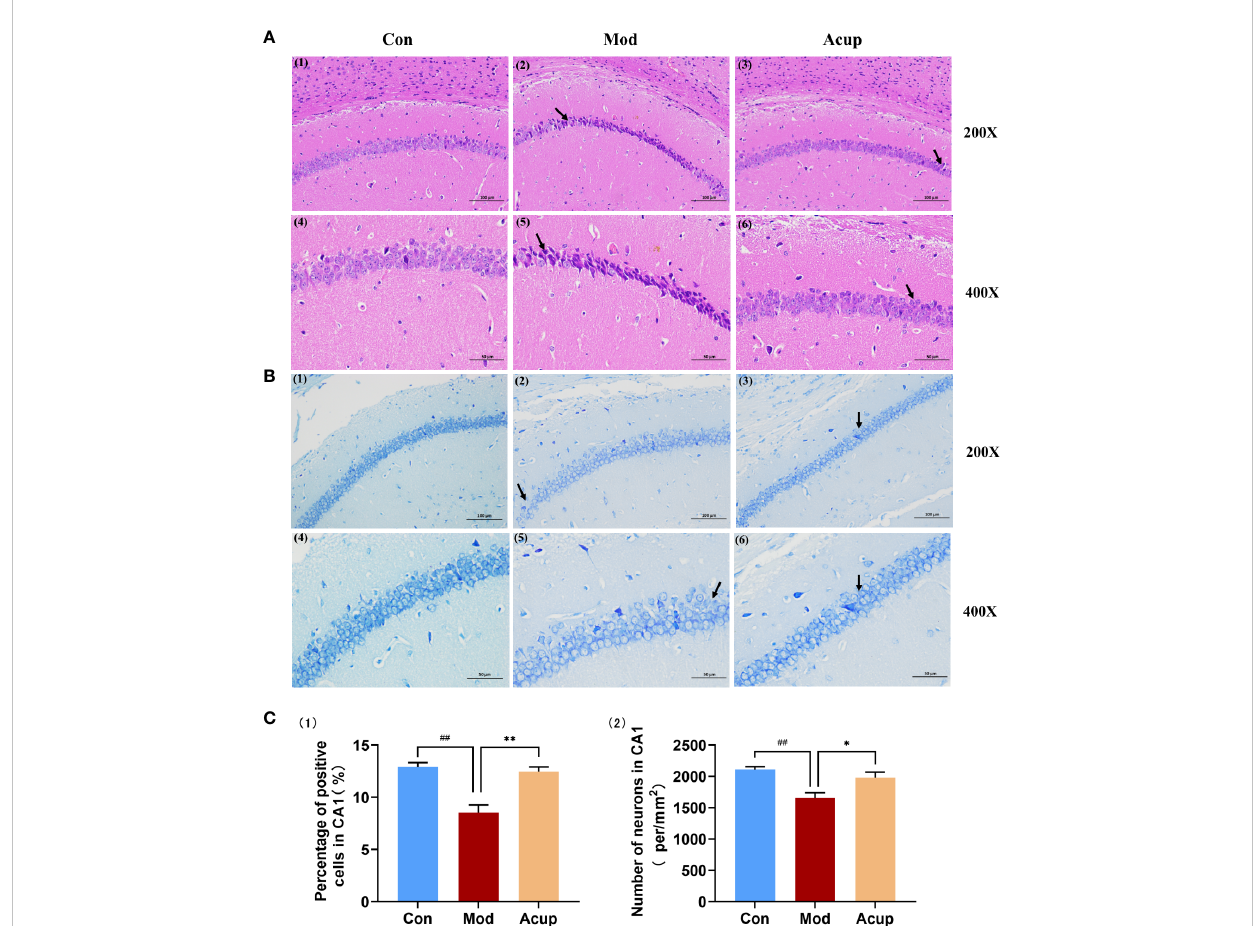
FIGURE 3 Electroacupuncture regulates morphological changes in the hippocampus of db/db mice. (A) The representative images of H&E stained mouse hippocampal sections in the three groups (20×/200×/400×). (B) The representative images of Nissl staining of the mouse hippocampal sections in the three groups (20×/200×/400×). (C) (1) Percentage of positive cells in the CA1 region of the mouse hippocampus; (2) Number of neurons per unit area in the CA1 region of the db/db mice ’ s hippocampus. Data are expressed as means ± SEM. Mod vs Con, ## p < 0.01; Acup vs Mod, * p < 0.05, ** p <